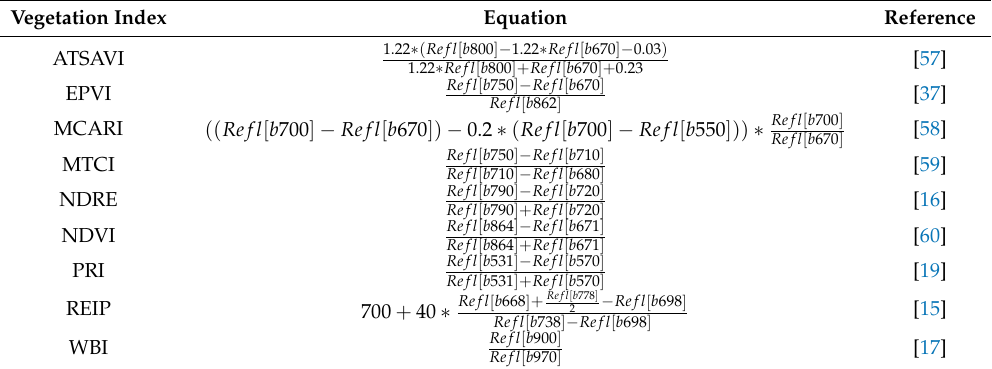
Table 2. List of tested hyperspectral vegetation indices, where b refers to the reflectance ( Refl ) in the respective spectral